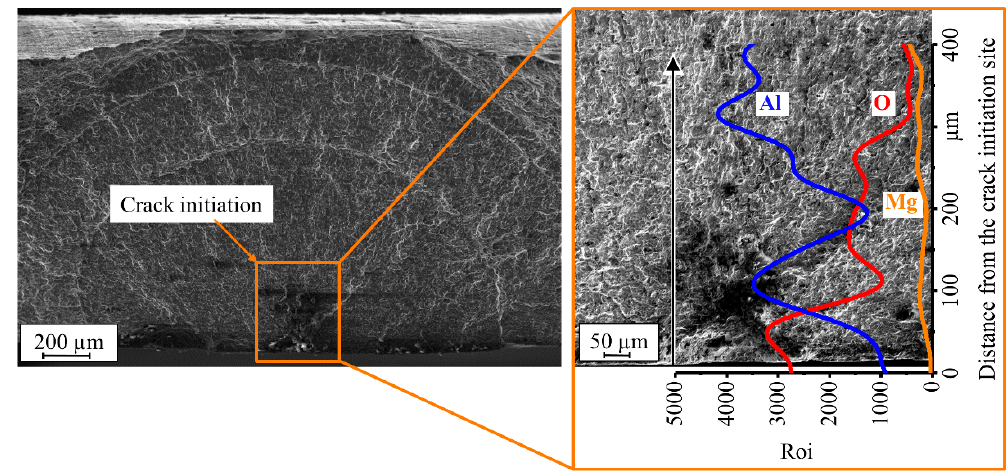
Figure 24. EDX analysis of the fractured surface of friction stir welded (FSW) EN AW-5754 specimen after the salt spray test.